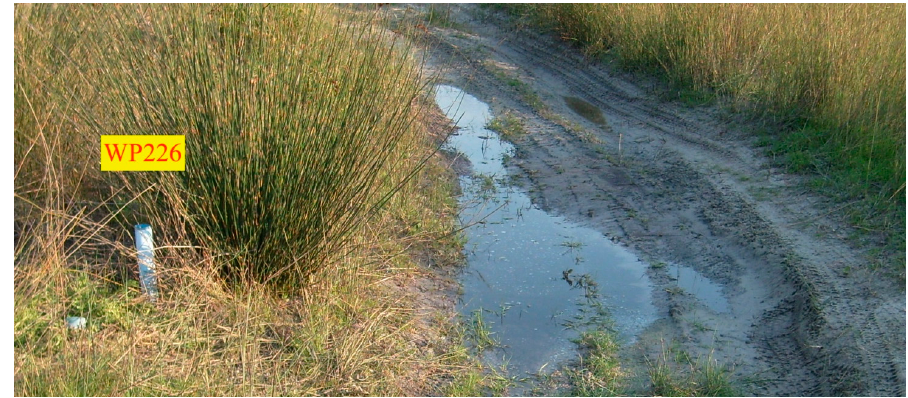
Figure 3. Photograph of WP226 at the Atlantis MAR system. The water level in the well was approximately equal to the surface of the small puddle.